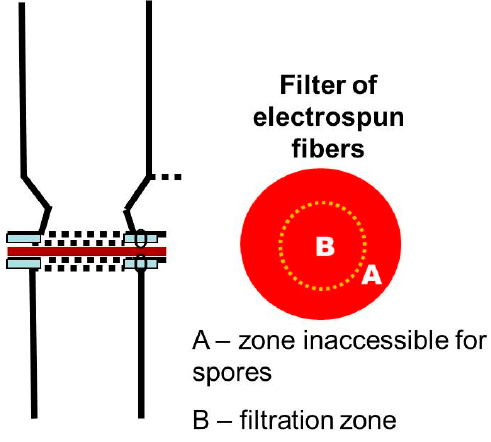
Figure 8. Schematic presentation of a filter position.